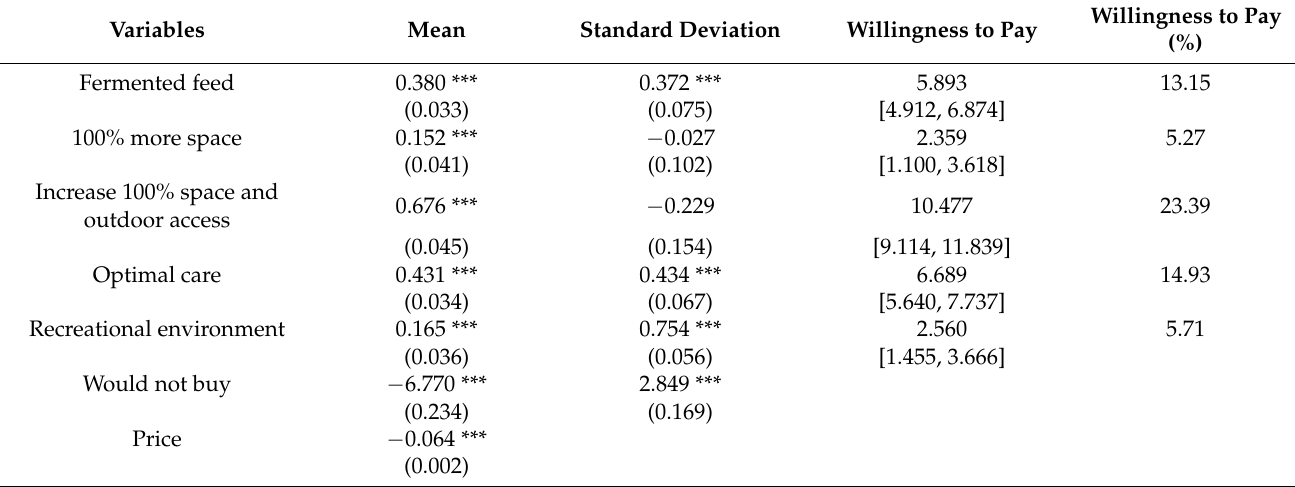
Table 3. Random parameter logit results of consumer preferences for animal welfare